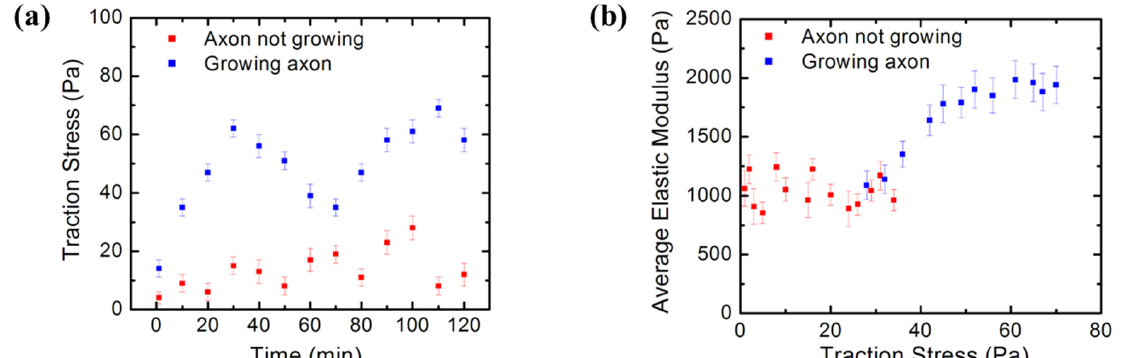
Figure 8. ( a ) Traction Force Microscopy data showing the time evolution of the traction stress for two different cells: a neuron with a growing axon (blue data points), and a different neuron with no active growing processes (red data points). The blue data points show that the growth dynamics is characterized by intermittent growth phases of relatively high traction stress, alternating with periods of low stress; ( b ) simultaneous AFM-TFM measurements of the variation of the average neuron elastic modulus (measured by AFM) with the traction stress exerted by the cell on the growth substrate (measured by TFM). Blue points show data measured for neurons with axons in the active growth phase. Red data points show measurements performed on neurons that are not undergoing active growth processes. Error bars in both figures represent the standard error of the mean. Both data series were acquired at t = 32 h after cell plating. The figure demonstrates that cortical neurons stiffen as the axons